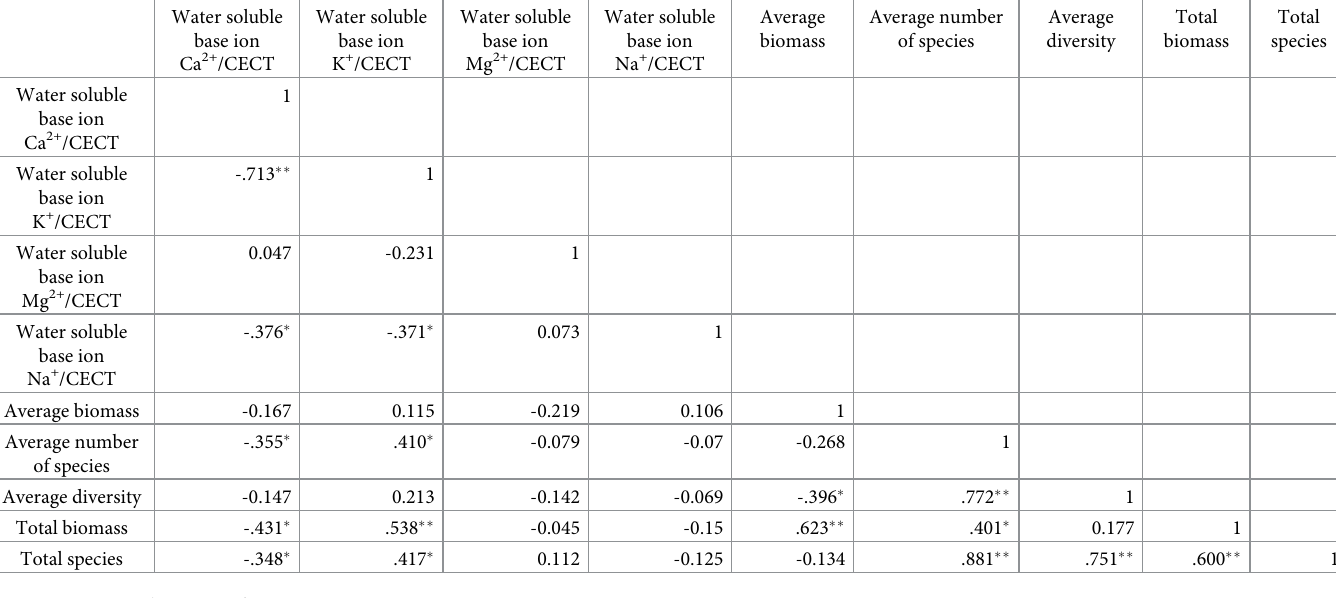
Table 1. Correlation analysis between effective water soluble base ion base ions and plant community